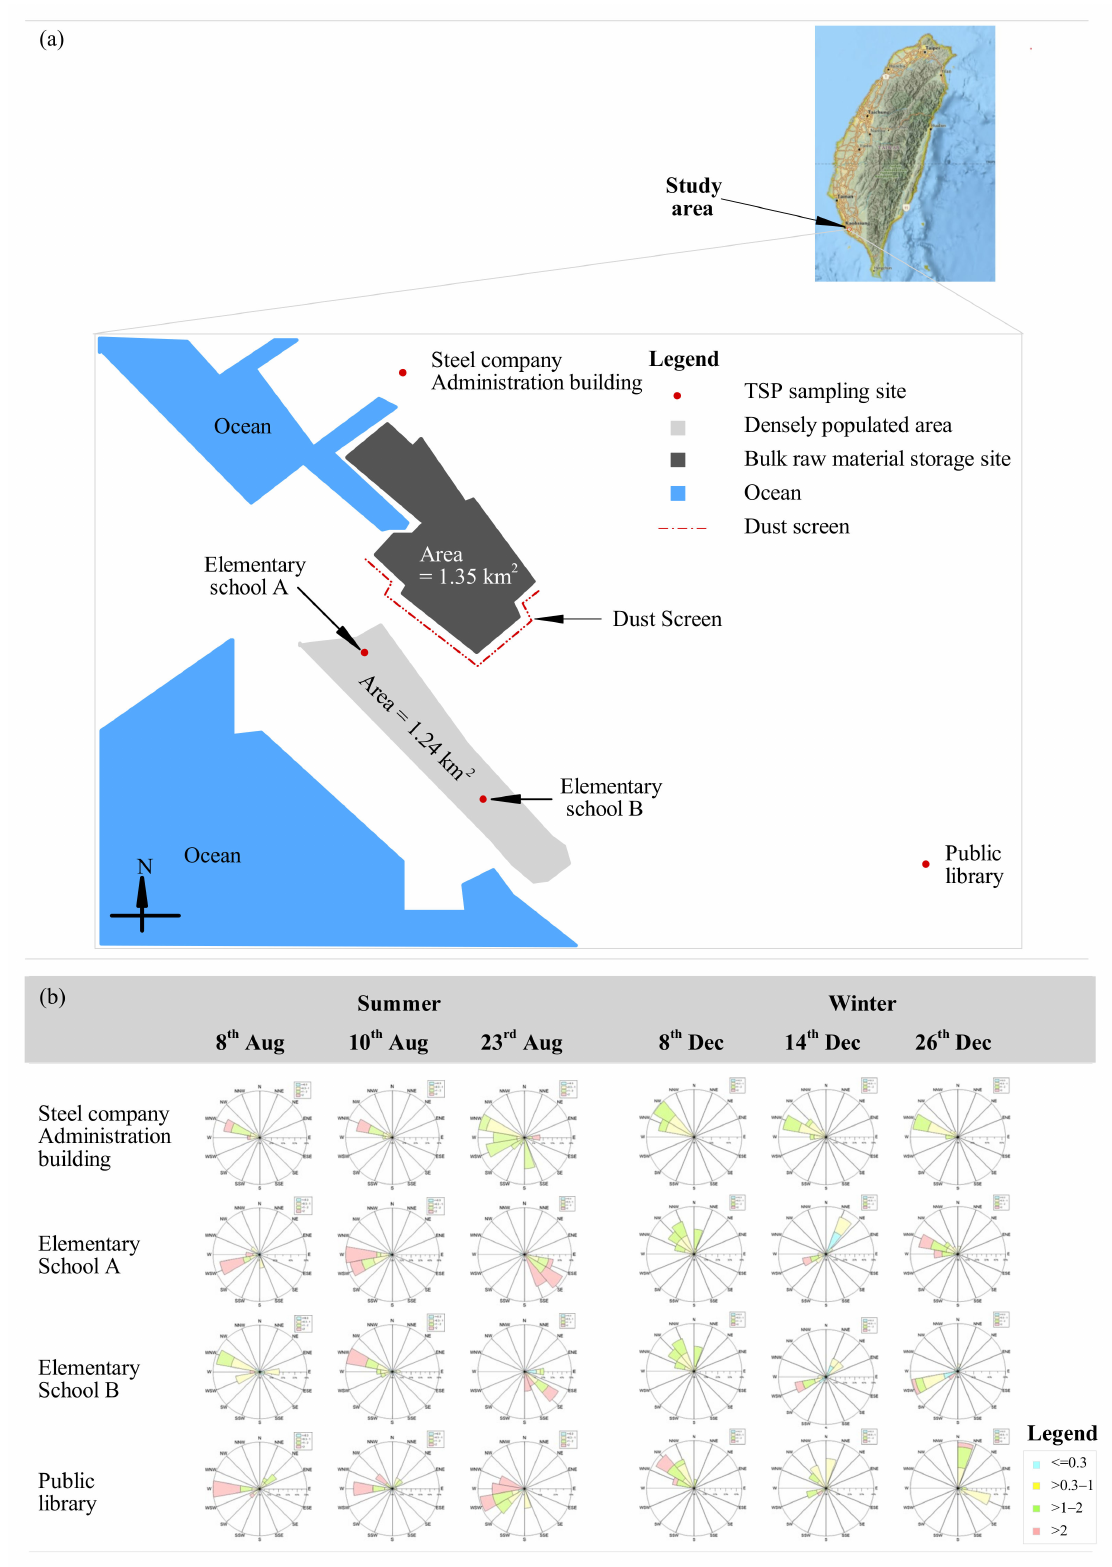
Figure 1. Schematic representations of ( a ) a plan view of the four TSP sampling sites and the sur- roundings of the raw material storage site and ( b ) wind rose maps for the TSP sample collection